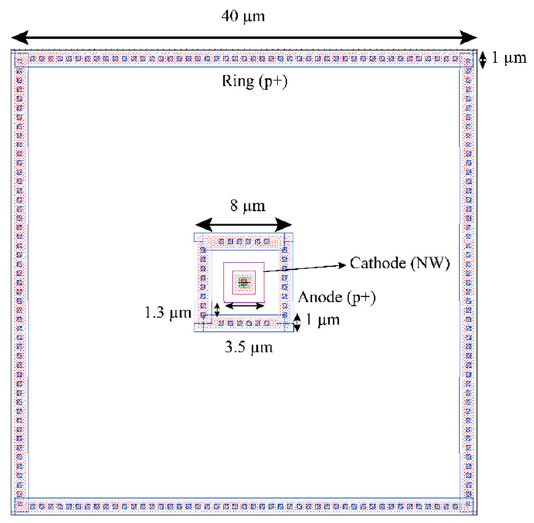
Figure 2. Dimensions of the CASPAD